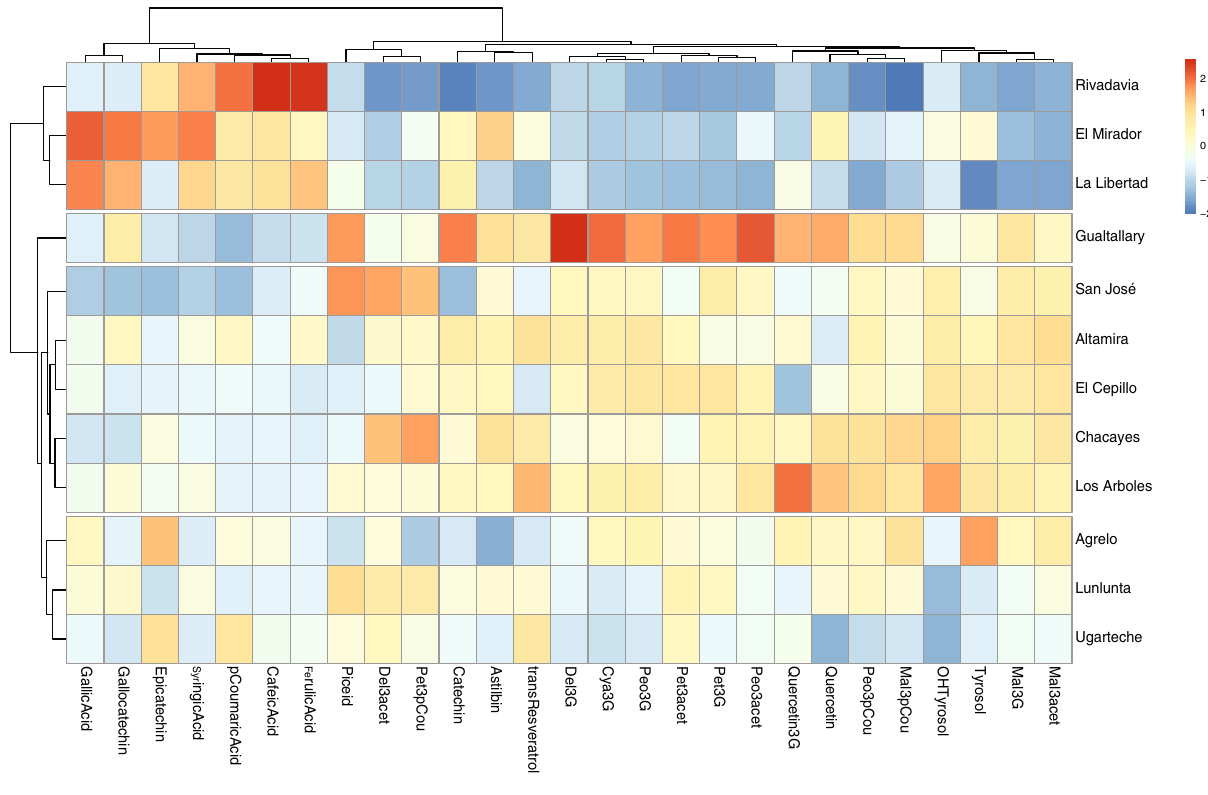
Figure 4. Hierarchical clustering of GIs (small areas) by phenolic composition. Values and cell colours indicate a relative concentration for each GI; blue corresponds to the minimum and red to the maximum value (“heatmap colours”). The figure was generated using Adobe Illustrator, version 22.1.0 (https ://www.adobe .com/ produ cts/illus trato r.html), R-package factoextra and R-package